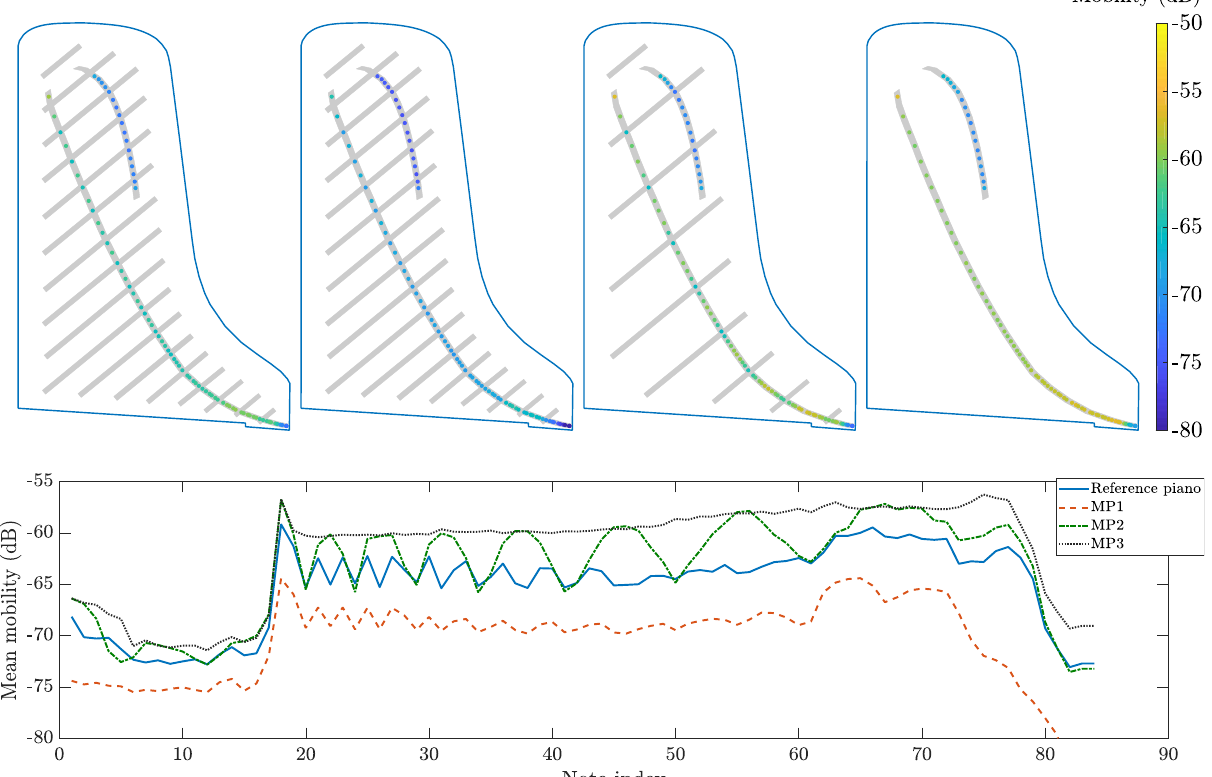
Figure 6. Mean mobility of the soundboard at the string-bridge coupling points. From left to right are the reference piano, the modi fi ed piano #1, the modi fi ed piano #2, and the modi fi ed piano #3. Bottom is the mean mobility as a function of the note index for the 4 virtual